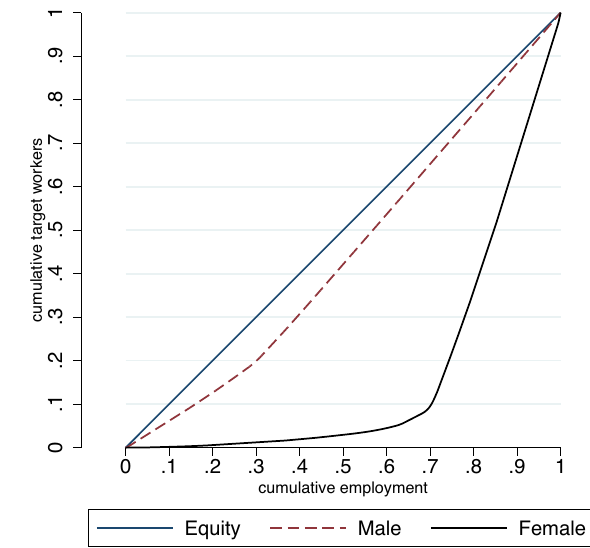
Fig. 1 Occupational segregation curve by gender. The fi gure shows the occupational segregation of male and female